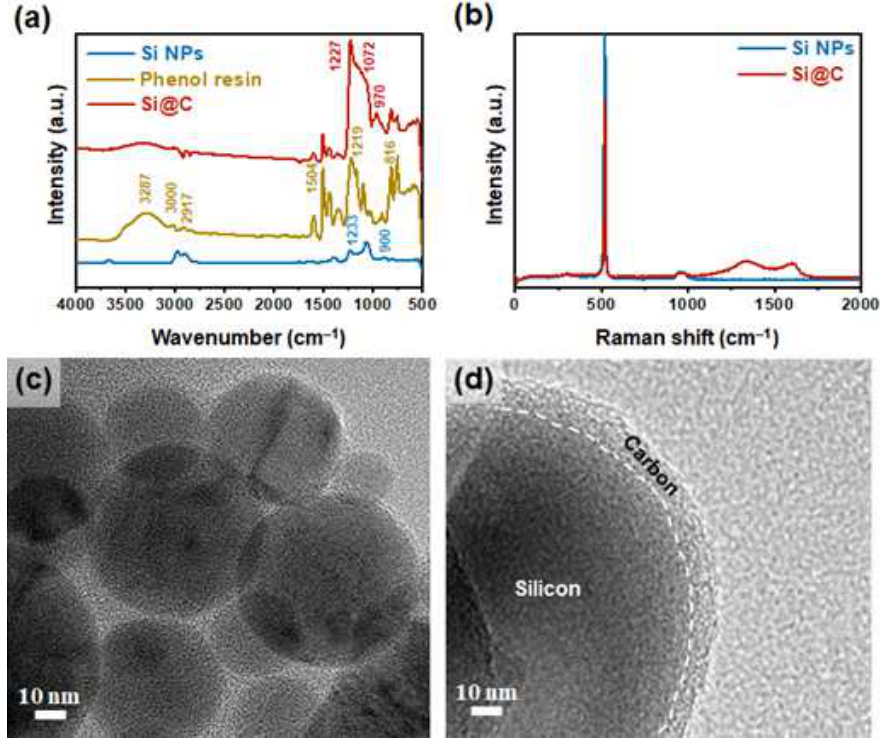
Figure 2. ( a ) FT−IR spectra of Si NPs, phenolic resin, and Si@C; ( b ) Raman spectra of Si and Si@C NPs; ( c , d ) TEM images of Si@C. NPs; ( c , d ) TEM images of